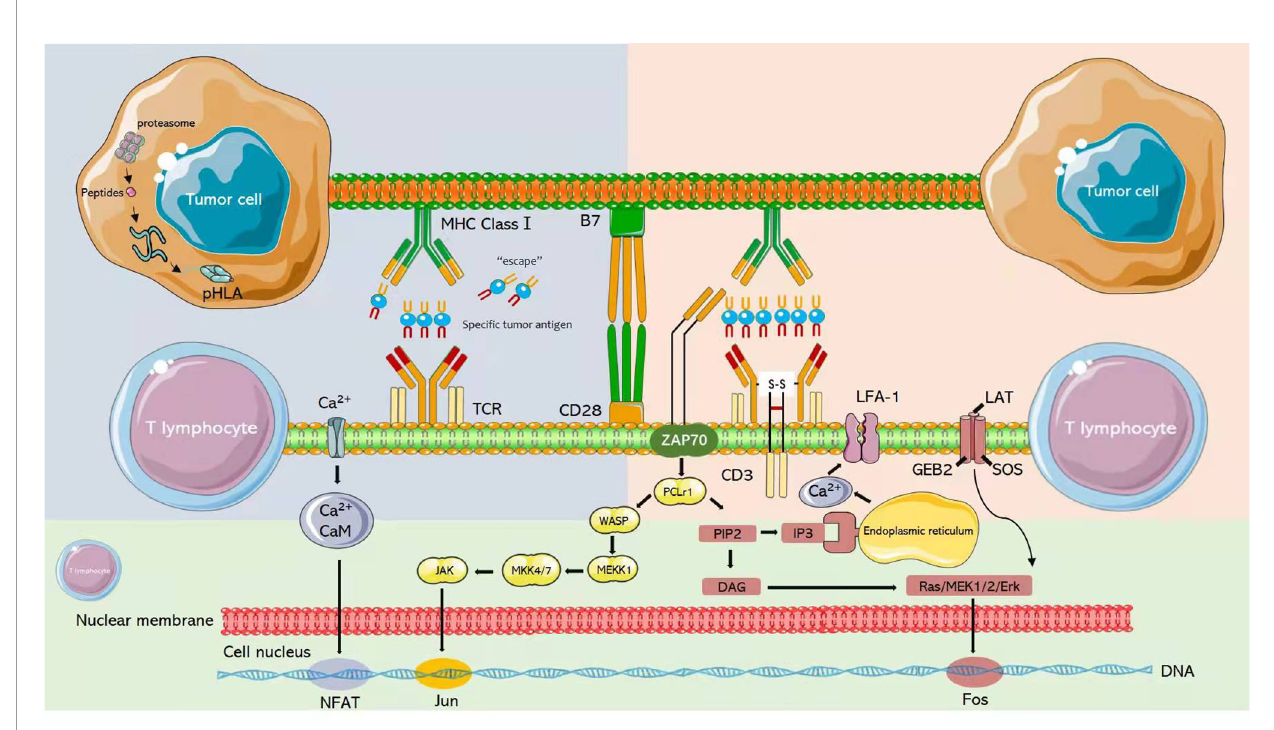
FIGURE 4 | After T cells interact with MHC through TCR, several proteins will be recruited to the plasma membrane to participate in signal